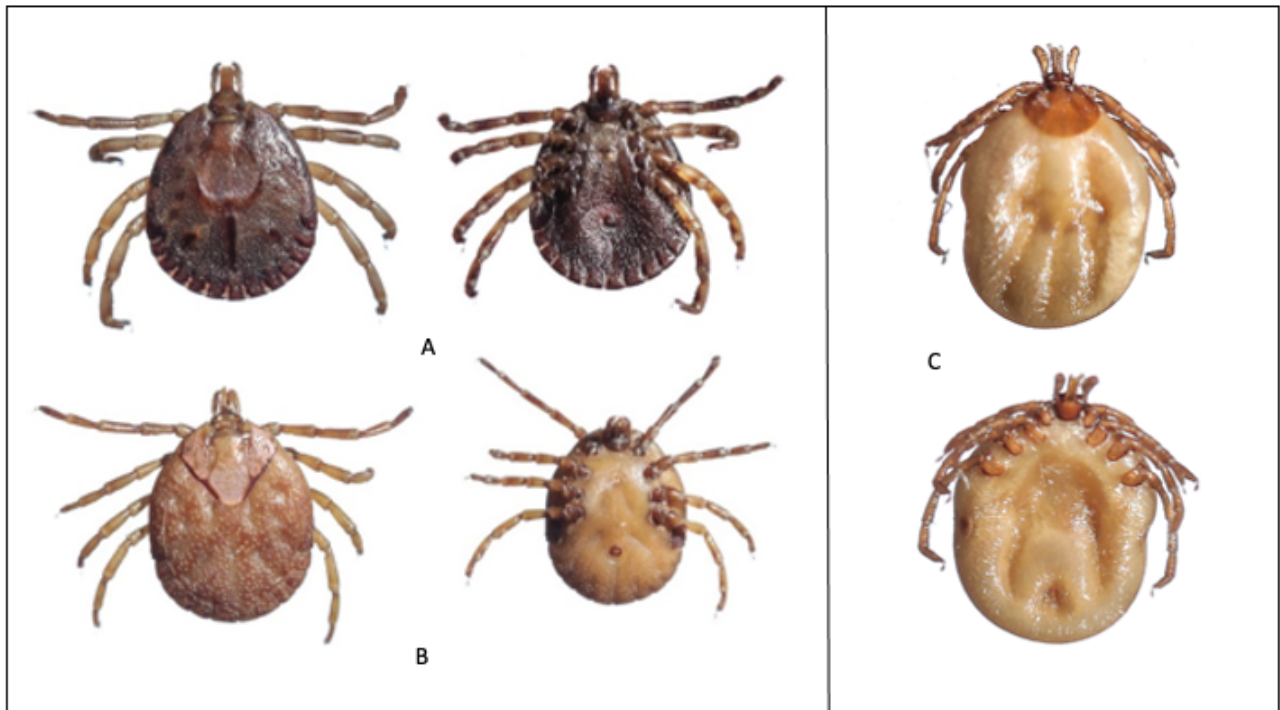
Figure 3. Dorsal and ventral views of male ( A ) and female ( B ) Haemaphysalis bispinosa ; and male ( C ) and female ( D ) Haemaphysalis spinigera .